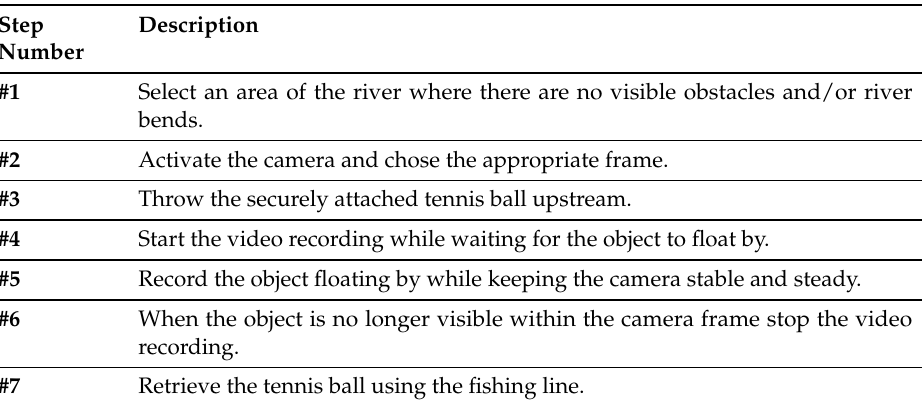
Table 3. Instructions for video